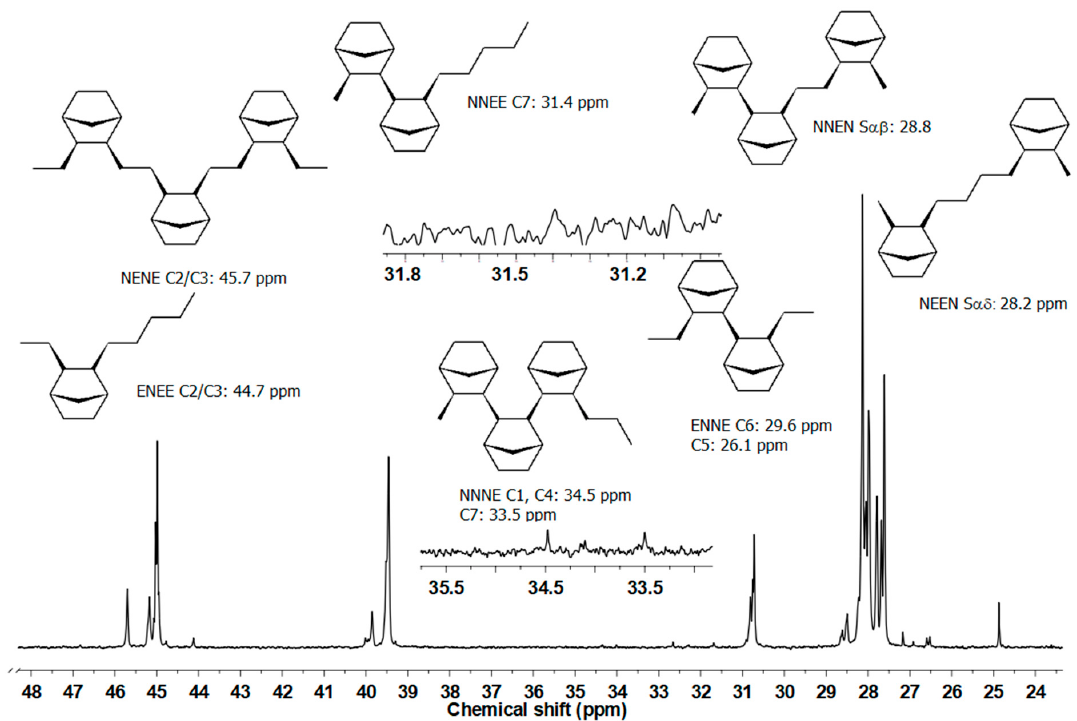
Figure 3. 13 C nuclear magnetic resonance (NMR) spectra of E-NB copolymer synthesized by SIL / C5 catalytic system.